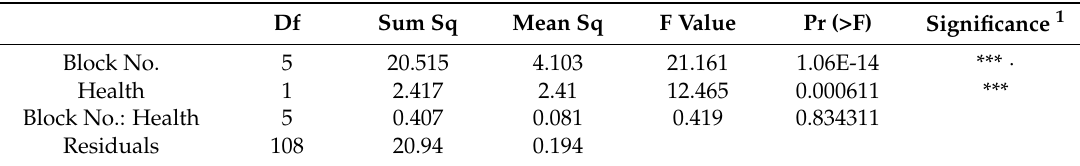
Table 4. Results of ANOVA analysis for temperature in relation to block number and the assumed block health.